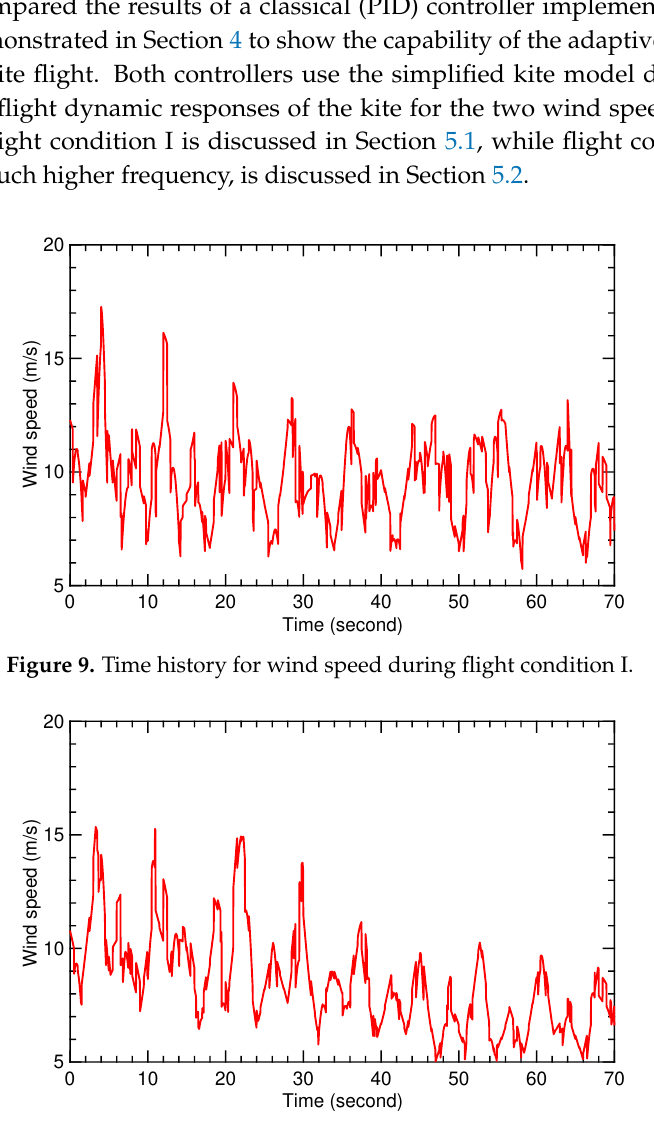
Figure 10. Time history for wind speed during flight condition